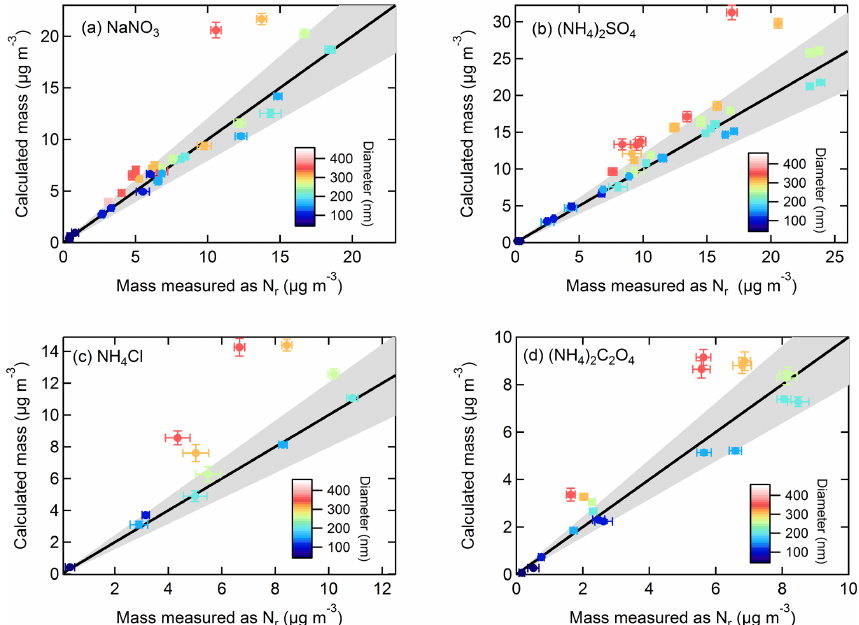
Figure 4. Calculated mass from particles size-selected by the DMA and corrected for multiply charged particles using SMPS-derived size distributions compared to aerosol mass concentrations (µgm − 3 ) measured as N r for (a) NaNO 3 , (b) ( NH 4 ) 2 SO 4 , (c) NH 4 Cl, and (d) ( NH 4 ) 2 C 2 O 4 . The particle size is designated by the color plot (error bars indicate ± 1SD) and the 1:1 line is shown in black with 20% error indicated by the grey